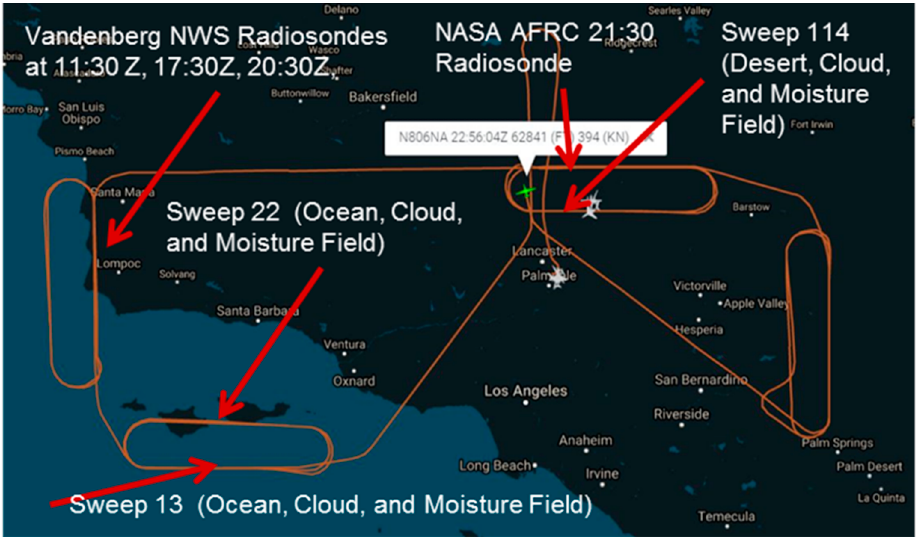
Figure 10. Flight path for NASA ER2 (carrying MISTiC airborne instrument) on 4 December 2017 included hyperspectral imaging observations of wind, temperature, and water vapor over the Channel Islands and nearby ocean, and over Vandenberg and Edwards Air Force Bases where radiosondes that provided an independent observation of weather conditions were launched.